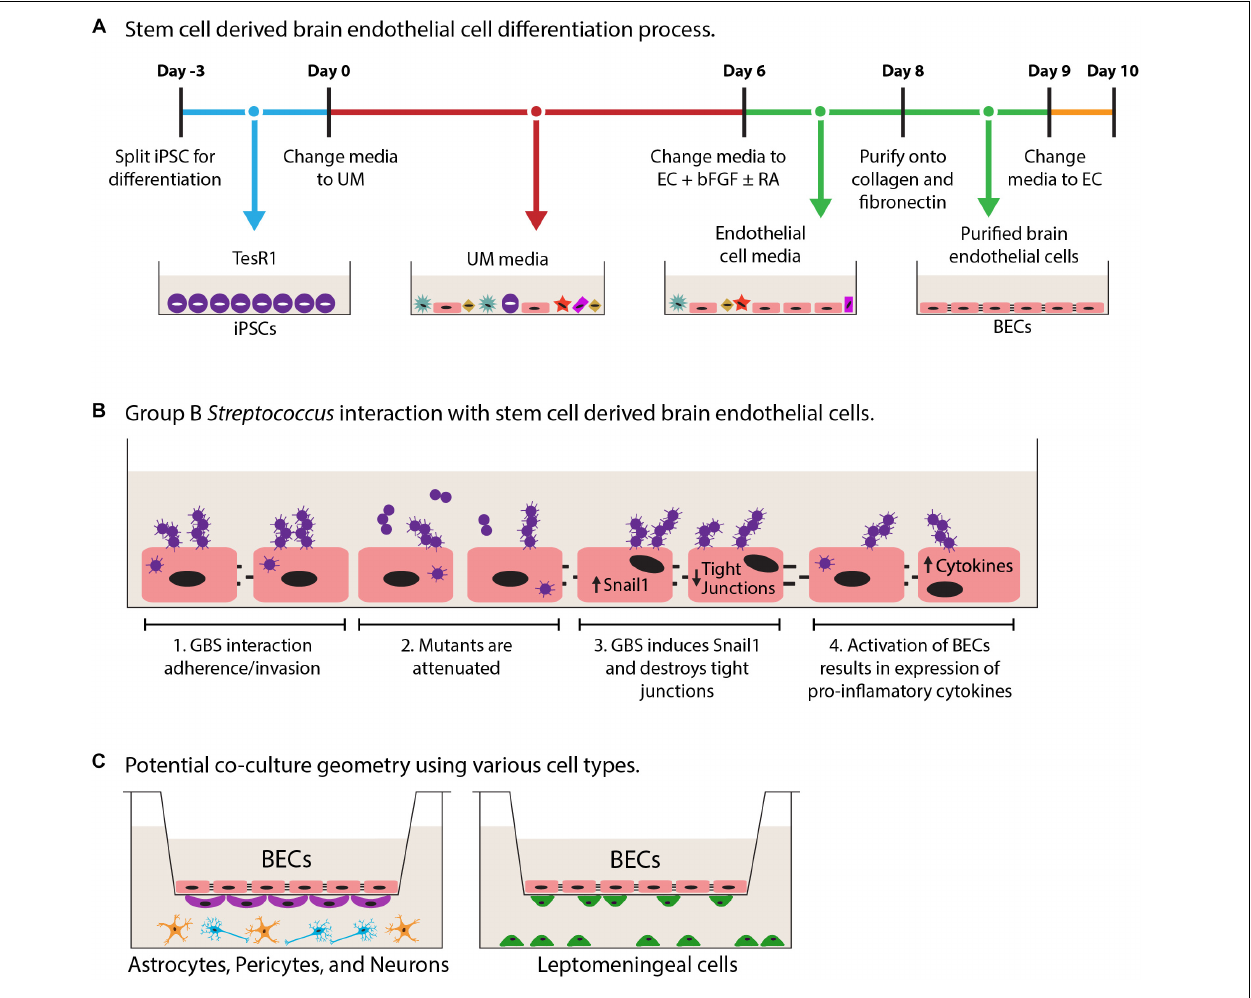
FIGURE 1 | Schematic diagrams of iPSC-derived BEC models and co-culture. (A) Derivation of iPSC-derived BECs adapted from Lippmann et al. (2012). Overall the 13-day process results in purified iPSC-derived BECs. Day-3 to 0 iPSCs are expanded in TesR1 media. Day 0–6, cells are differentiated in unconditioned media (UM). Days 6–9, endothelial cells are expanded using endothelial cell (EC) media supplemented with basic fibroblast growth factor (bFGF), and retinoic acid (RA). On day 8 endothelial cells are purified onto a collagen/fibronectin matrix. Day 9 cells get a final change into EC media. (B) Schematic GBS infection of iPSC-BECs